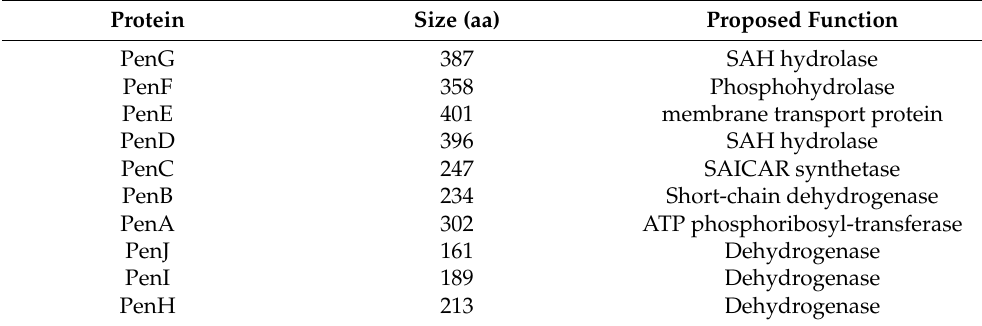
Table 2. The proposed functions of proteins in the biosynthesis gene cluster of PNT and Ara-A in the Streptomyces antibioticus NRRL